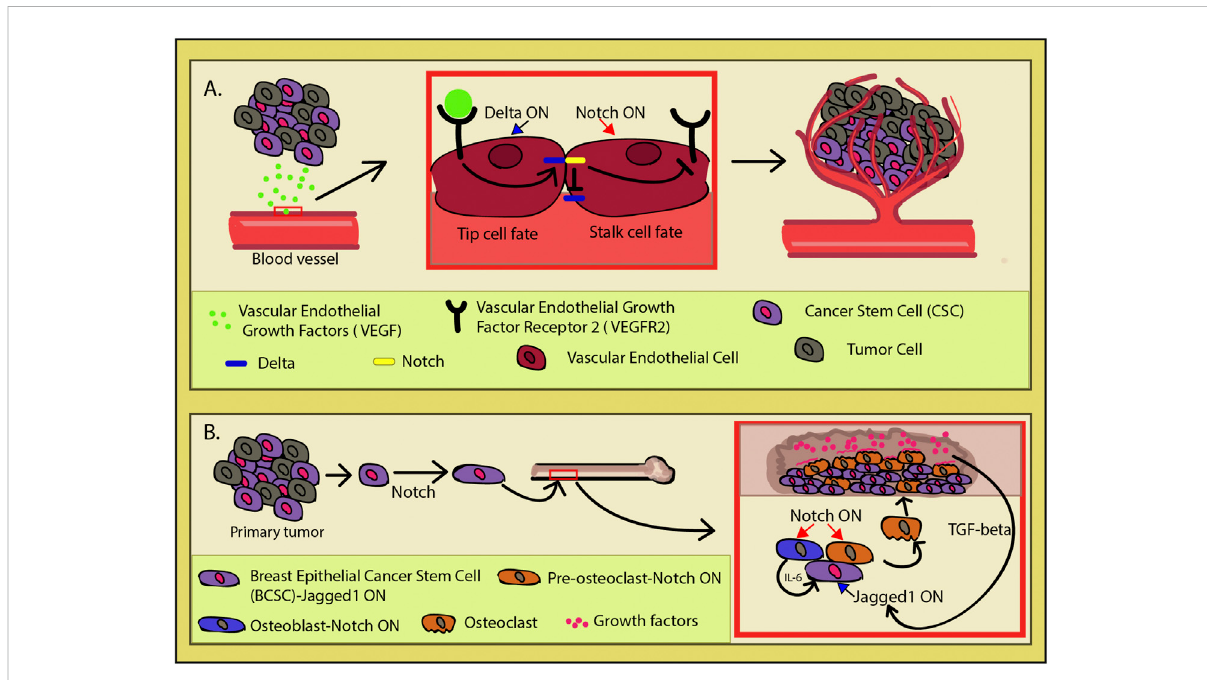
FIGURE 5 Cancer-induced angiogenesis. (A) Cancer stem cells (CSCs) secrete vascular endothelial growth factors (VEGFs) which induces in the nearby endothelium the process of vascular budding. VEGF activation upregulates Delta-like ligand 4 (Dll4) (blue) expression. In order to achieve functional vasculature during angiogenesis, endothelial cells need to acquire one of two cell fates (tip or stalk). These two phenotypes are necessary for a functional vasculature and exhibit different behaviors. The tip cell has migratory qualities and leads the nascent vasculature toward the VEGF source, while the stalk cells have a supportive role in the angiogenesis. Dll4 induction in an endothelial cell induces lateral inhibition in its neighbor throughNotch(yellow)activationwhichinturninhibitsDll4andvascularendothelialgrowthfactorreceptor2(VEGFR2)expression(redsquare).This whole process is a two-way street, as the CSCs directly induce angiogenesis, while the newly formed vasculature network actively promotes the stem cell features of the CSCs, making it the perfect cancer niche. (B) In breast cancer, after the primary tumor is established, some breast epithelial cancer stem cells (BCSCs) (purple) go through biochemical changes and undergo the Notch-mediated loss of some epithelial characteristics. This transformationconferscellcapacitytomigrateandinvadenewtissues.Inparticular,cellshaveanaf fi nitytowardboneastheyinitiateaself-sustained program of invasion. By expressing Jagged1 (JAG1), theyare able to induce Notch in theosteoblasts (blue) and osteoclasts (orange). Osteoblasts will thensecreteIL-6,promotingtumorgrowth,whileosteoclastsgointoosteoclastogenesisanderodethebone,makingspacefortheexpandingmass. Bone destruction releases growth factors (pink), initiating the TGF- β pathway which upregulates JAG1 in the invading cancers cells and reinforcing the vicious